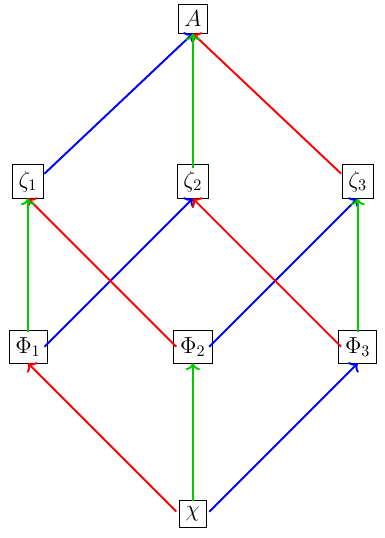
in eq. (2.7) are shown explicitly by colored arrows. a , respectively. The S operations are a 1 , 2 , 3